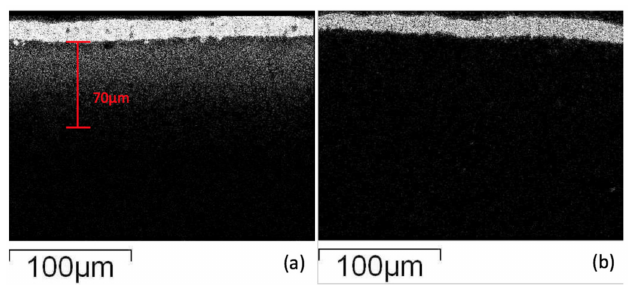
Figure 4. X-ray mapping of scanning electron microscopy (SEM)–energy dispersive X-ray spectroscopy (EDS) micrographs showing silver distribution for specimens of ( a ) CaO-MgO-2SiO 2 stoichiometric composition; ( b ) modified CaO-MgO-2SiO 2 system.